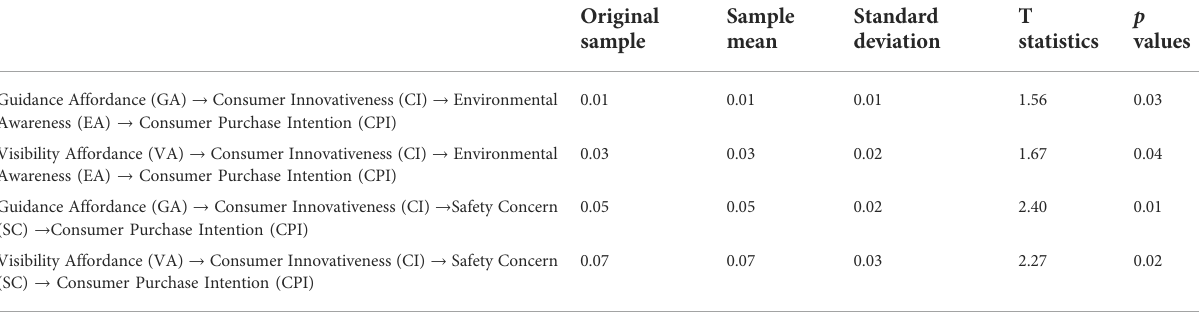
TABLE 7 Indirect effect through SmartPLS